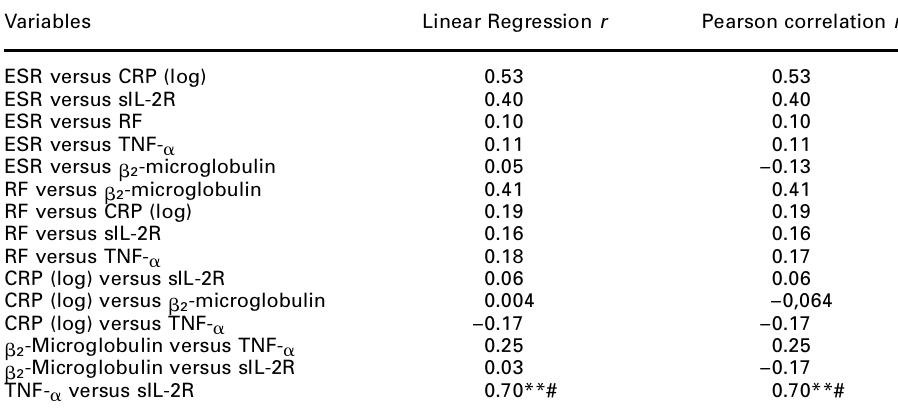
Table 2. +Correlation r values among the studied variables ( n = 27) Variables Linear Regression